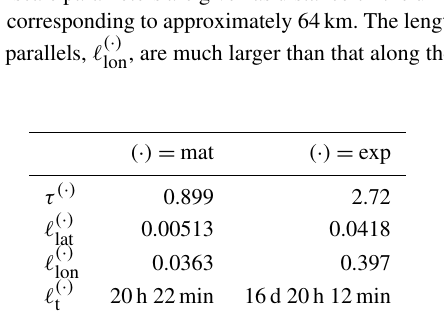
Table 3. Lower and upper limits, with true and estimated parame- ter values. The three-kernel synthetic covariance function parameter estimation problem is already very difficult, here resulting in slight overestimation of the parameters of the smallest kernel.